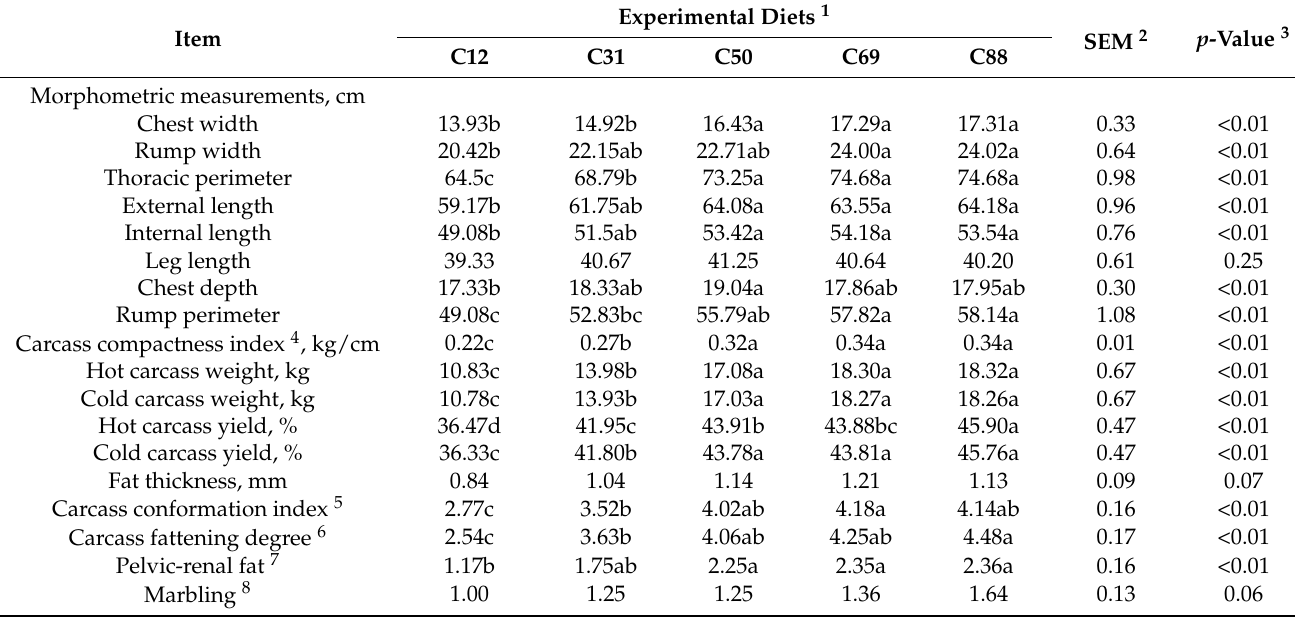
Table 4. Effect of dietary forage-to-concentrate ratios on morphometric measurements and carcass traits of